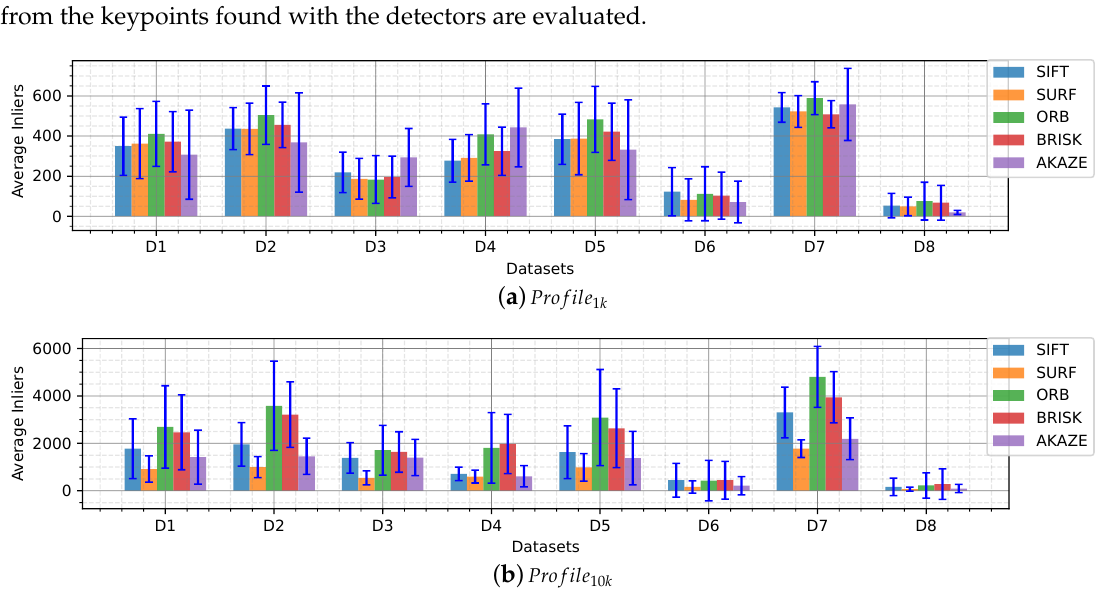
Figure 7. Inliers, obtained after NN matches and homography, per